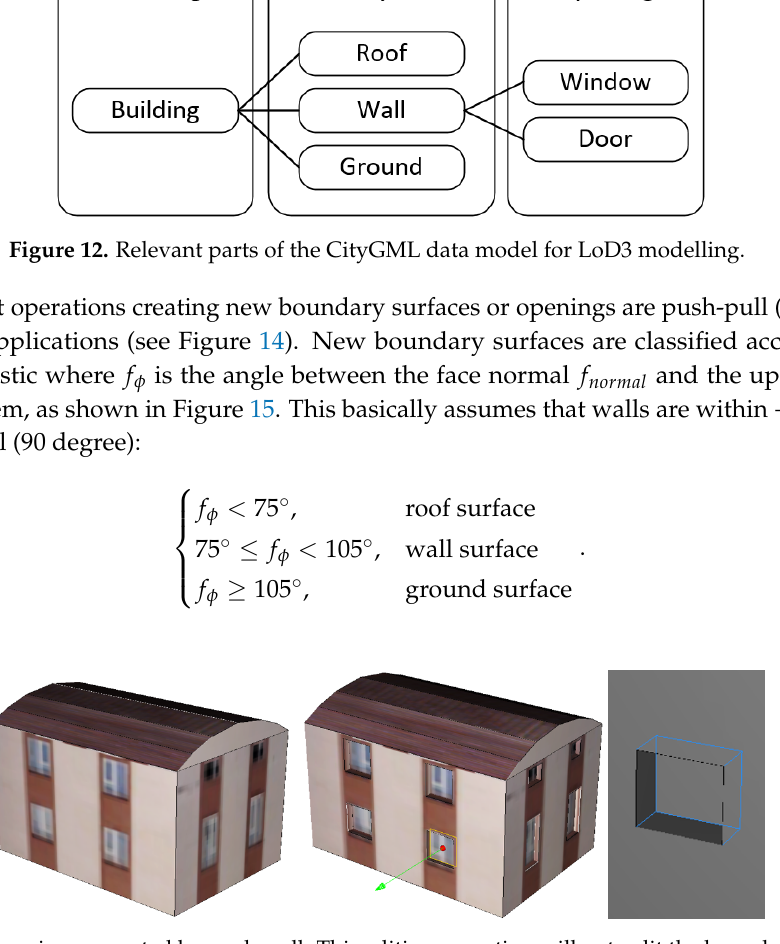
Figure 13. Opening generated by push-pull. This editing operation will not split the boundary surface but generate a hole on the boundary surface.